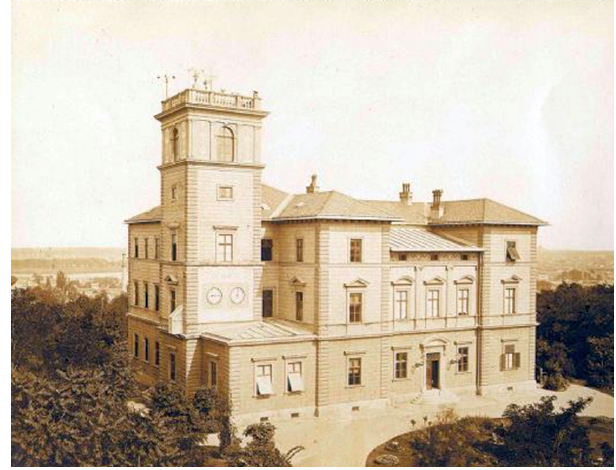
Figure 2. Home of ZAMG since 1872 at the Hohe Warte in Vienna (ZAMG